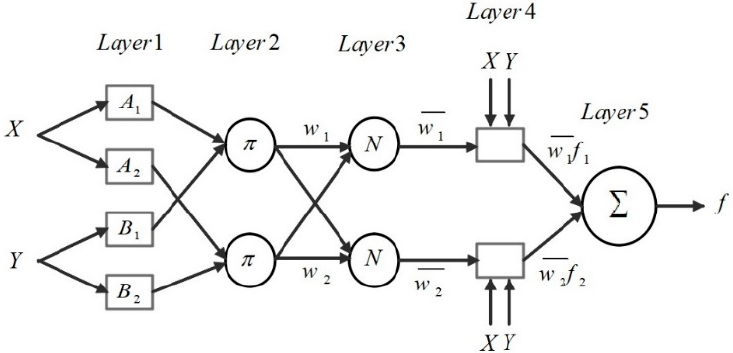
Figure 4. Architecture of adaptive neuro-fuzzy inference system (ANFIS) used to model the evap- orator.